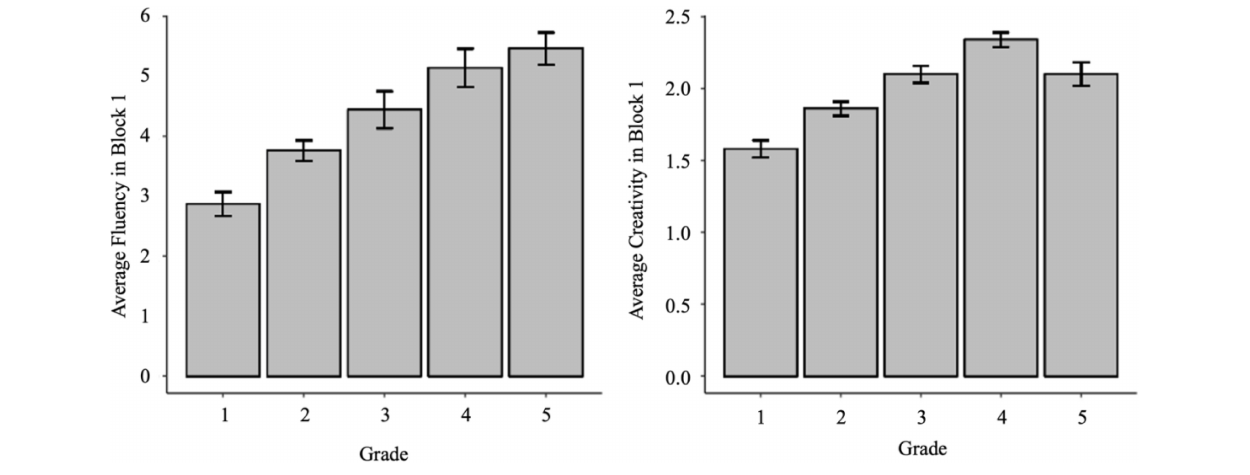
FIGURE 1 | Average fluency and creativity in block 1 across grade. Error bars represent ± 1 standard